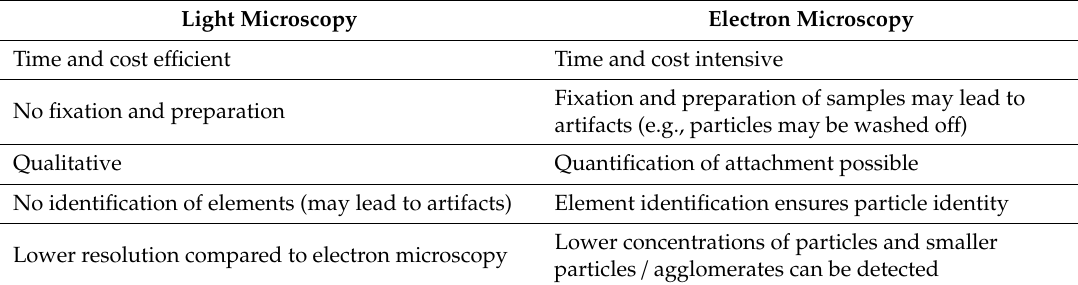
Table 3. Advantages and disadvantages of light and electron microscopy for the observation of particle–cell